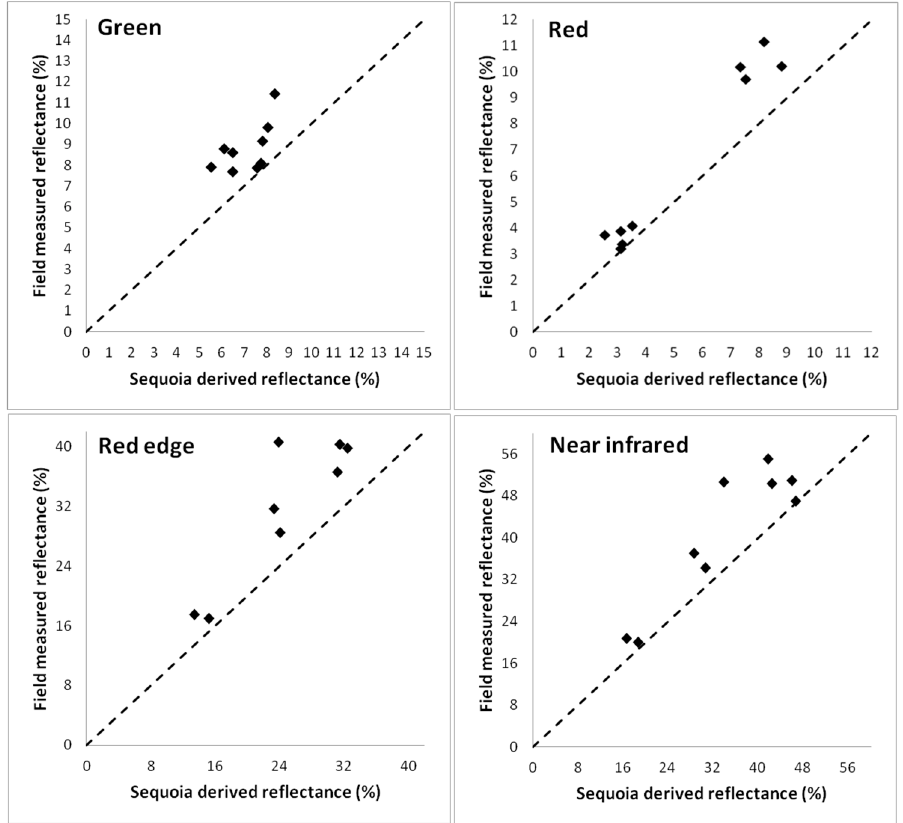
Figure 18. Correlation between the reflectance map (Sequoia) and field spectral data for the nine spectral field plots. Green band R 2 = 0.39, red band R 2 = 0.97, red-edge band R 2 = 0.80, and near-infrared band R 2 = 0.84. Table 6. Equation and R 2 for the regression between reflectance from the Sequoia camera and the field spectral measurements, where y is the field spectral data and x is Sequoia reflectance. NDVI, normalized difference vegetation index.